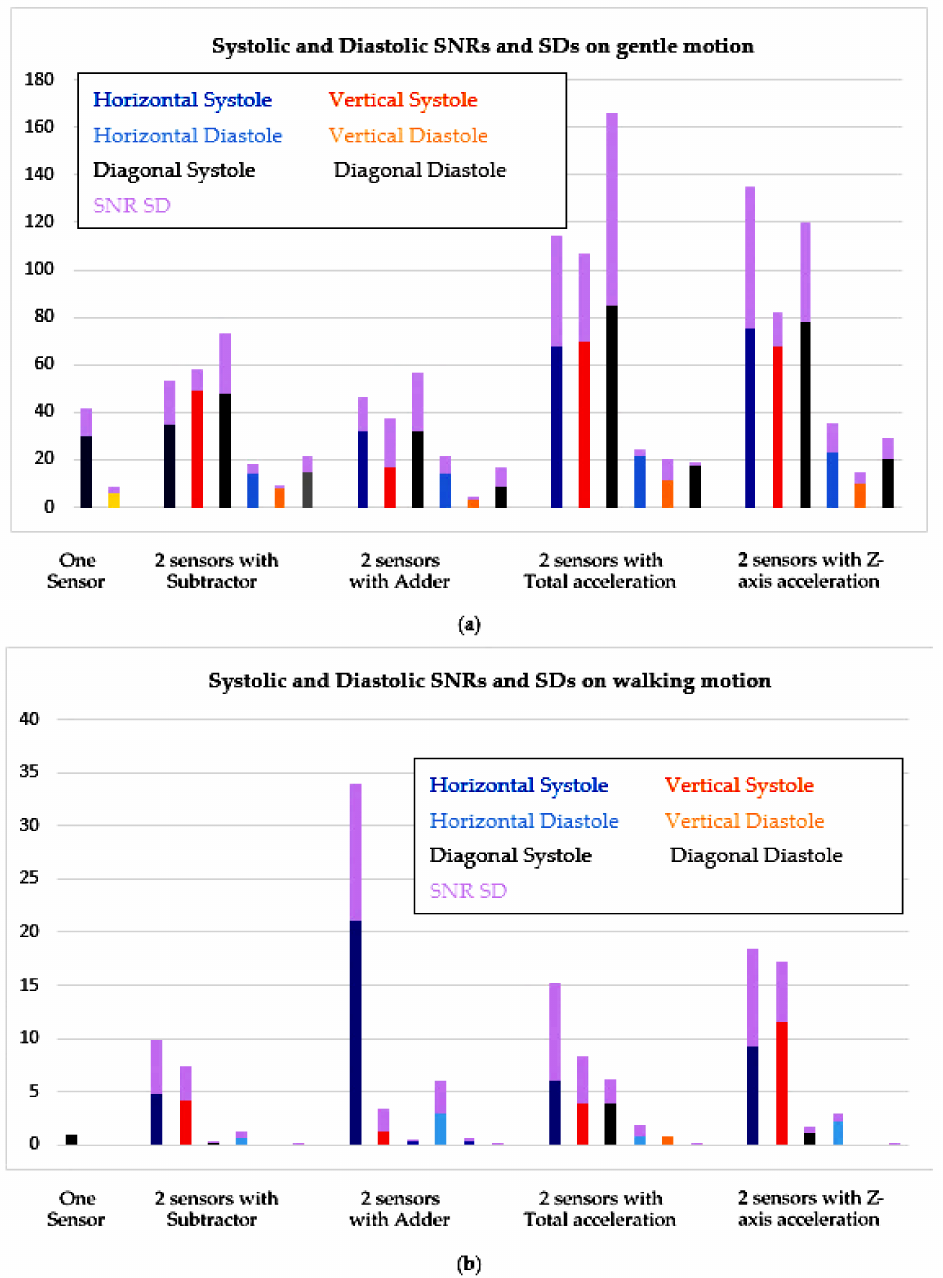
Figure 12. Comparison of SNRs on one sensor and two-sensor methods. ( a ) Gentle movement; ( b )